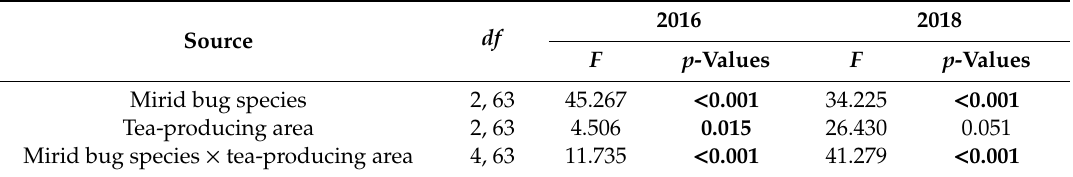
Table 1. Generalized linear models (GLM) parameters for e ff ects of mirid bug species and tea-producing area on the numbers of mirid bugs.